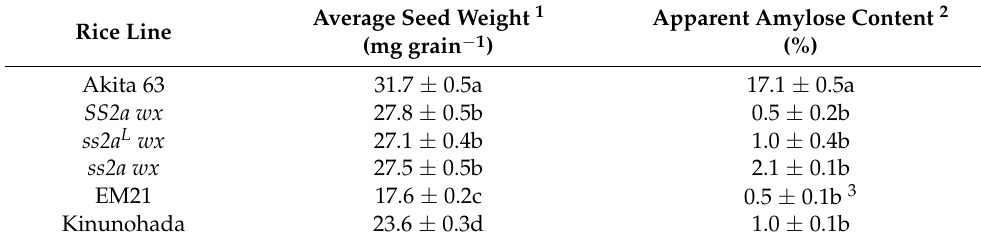
Table 2. Seed weight and amylose